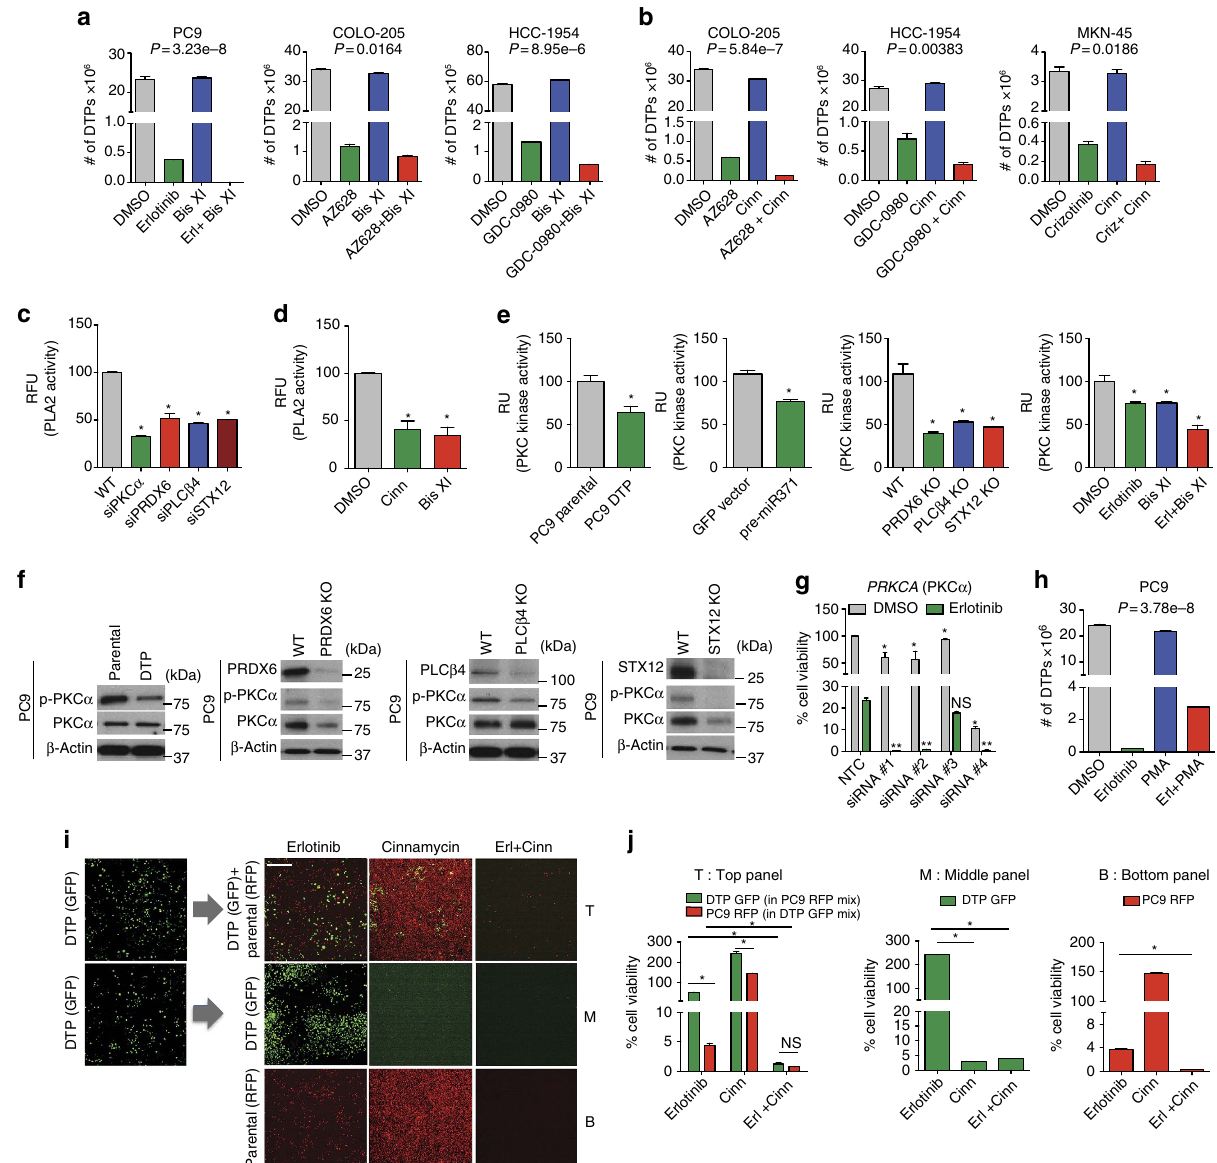
Figure 3 | Downregulation of PRDX6/PLC b 4-associated PLA2/PKC a activity inhibits drug tolerance. ( a ) Co-treatment with bisindolylmaleimide XI reduces DTPs in PC9, COLO-205 and HCC-1954 cells. ( b ) Co-treatment with cinnamycin reduces DTPs in COLO-205, HCC-1954 and MKN-45 cells. Decreased PLA2 activity upon ( c ) siRNA knockdown of PRDX6 , PLC b 4 or STX12 and ( d ) treatment with PLA2 inhibitors cinnamycin and the PKC a inhibitor bisindolylmaleimide XI. * indicates significant differences from wild-type (WT) or DMSO controls. ( e ) PKC activity in PC9 cells and DTPs, stable cell lines expressing pre-miR-371 or PRDX6 , PLC b 4 or STX12 knockouts and upon treatment with bisindolylmaleimide XI ± erlotinib. * indicates significant differences from DMSO or WTcontrols. ( f ) Immunoblot of PKC a activation in PC9 DTPs and PC9 cells with PRDX6 , PLC b 4 or STX12 knockouts. ( g ) si PRKCA knockdown in PC9 cells reduces DTPs. * and ** indicate significant differences from DMSO- and erlotinib-treated NTC controls respectively. ( h ) Co-treatment with the PKC activator phorbol-12-myristate13-acetate (PMA) increases DTPs in PC9 cells i , Fluorescence microscopy images of surviving PC9 DTPs co-cultured with parental cells (T: top panel), PC9 DTPs (M: middle panel) or parental cells (B: bottom panel) after 6-day treatment with cinnamycin ± erlotinib, Scale bar, 50 m m and ( j ) viable cell population counts of imaged cells in f on day 6 of treatment. All experiments were performed in triplicate and data are representative of at least two independent experiments. Data are represented as mean ± s.e.m. For c – e and g , * or ** P o 0.05, Student’s t -test, NS, not significant. For a , b and h , P represents interaction P